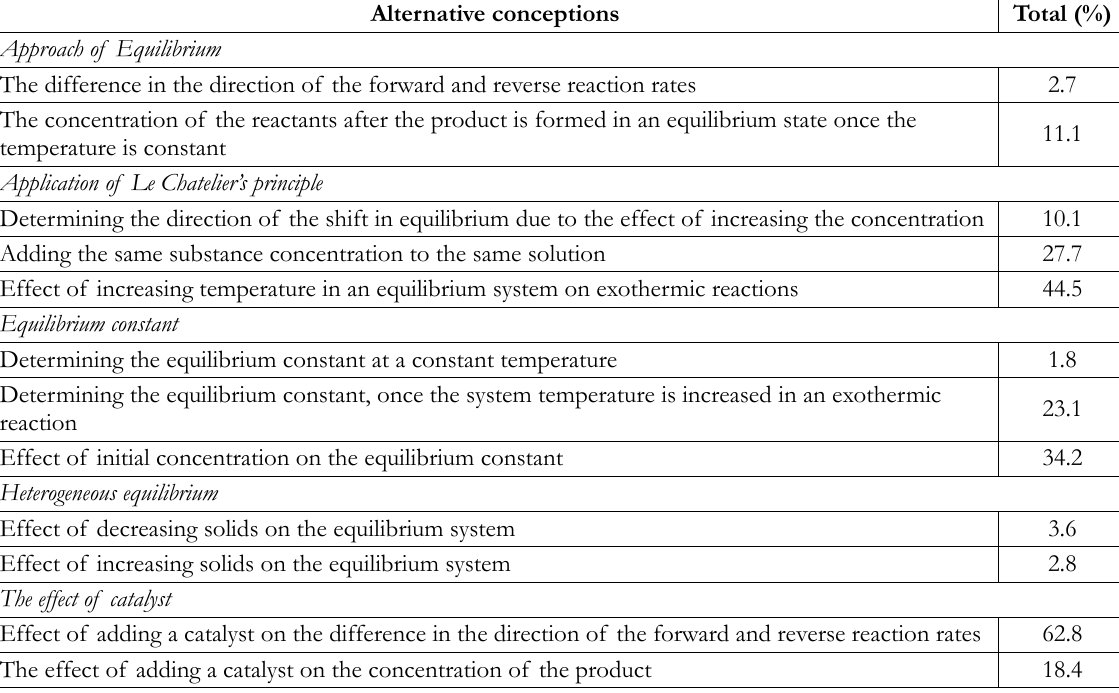
Table 8. Percentages of students’ alternative conceptions